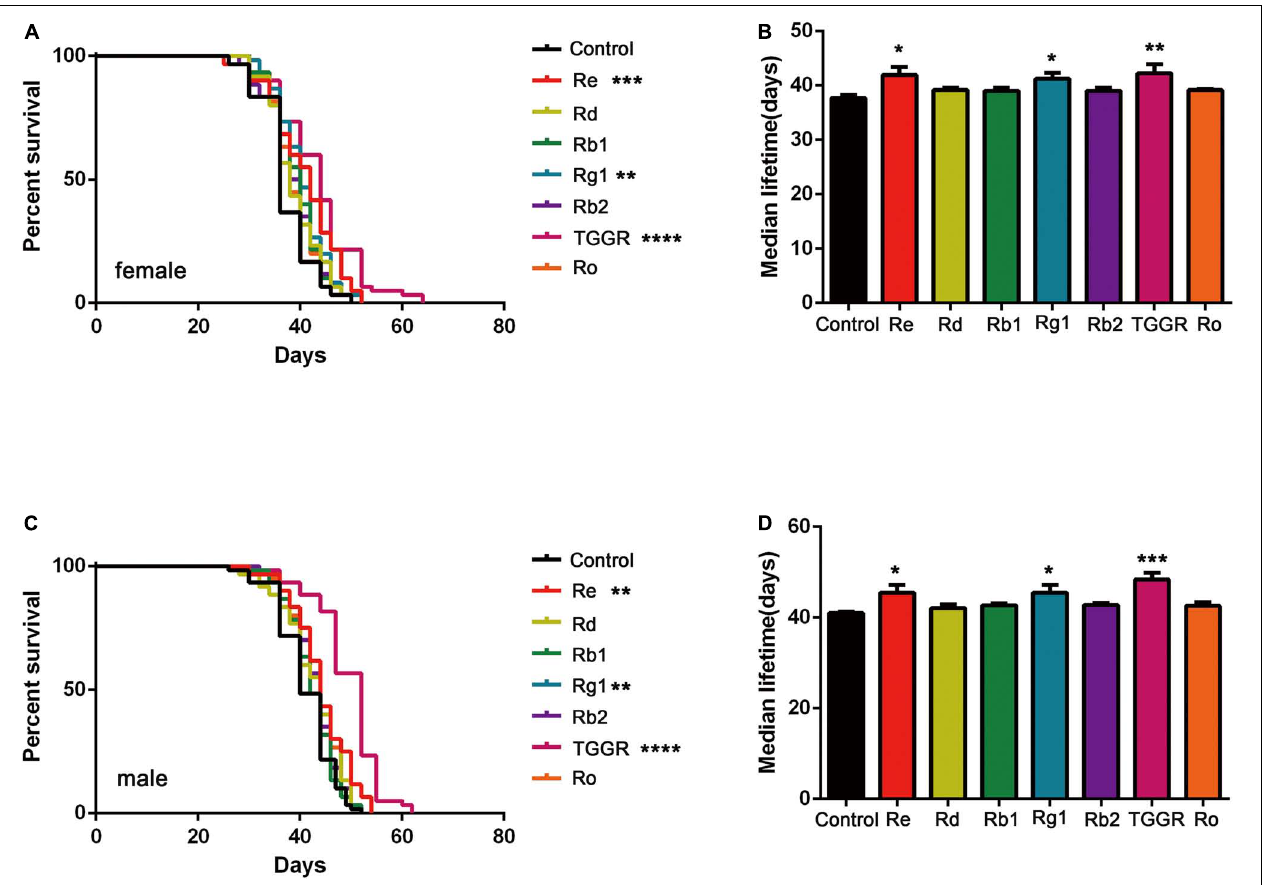
FIGURE 10 | The effect of TGGR monomer components on longevity in Drosophila. Survival of female (A) or male (C) flies treated with TGGR or different ginsenosides [ N = 60 flies per condition, Log-rank (Mantel-Cox) test]; The median lifespan of female (B) or male (D) flies treated with different ginsenosides ( N = 60 flies per condition, One-way ANOVA). The flies were treated with the following drug concentrations: Re (300 µ g/mL), Rd (500 µ g/mL), Rb1 (300 µ g/mL), Rg1 (500 µ g/mL), Rb2 (300 µ g/mL), TGGR (5 mg/mL), Ro (300 µ g/mL). * p < 0.05, ** p < 0.01, *** p < 0.001, **** p < 0.0001 vs. the